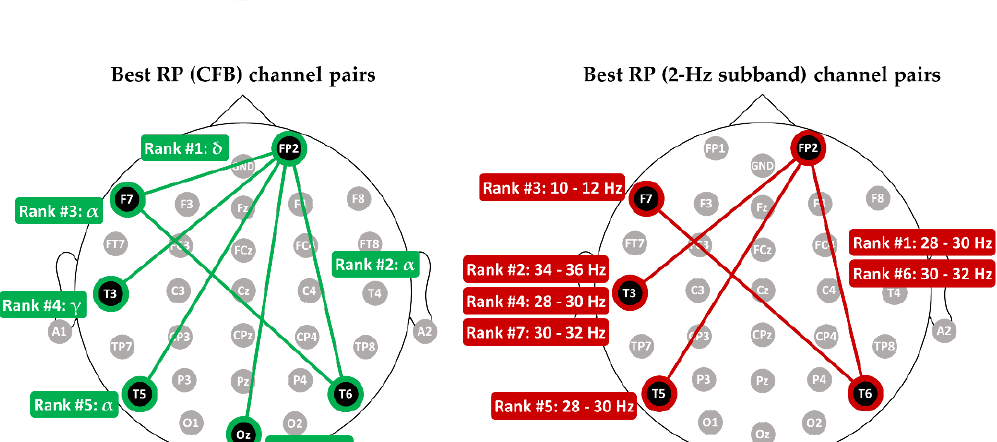
Figure 5. The best feature subsets of the BP (CFB), SE-RP (CFB), RP (CFB), and RP (2-Hz subband) features. ( Upper-left ) : the best set for BP includes beta (top-1-ranked) and gamma (top-2-ranked) BPs, and their electrode locations are at FP2. ( Upper-right ): the best set of SE-RP includes nine features at five different electrode channels. ( Bottom-left ) : the best set of RP (CFB) includes six features from six different electrodes. ( Bottom-right ) : the best set of RP includes seven features from five different electrodes.